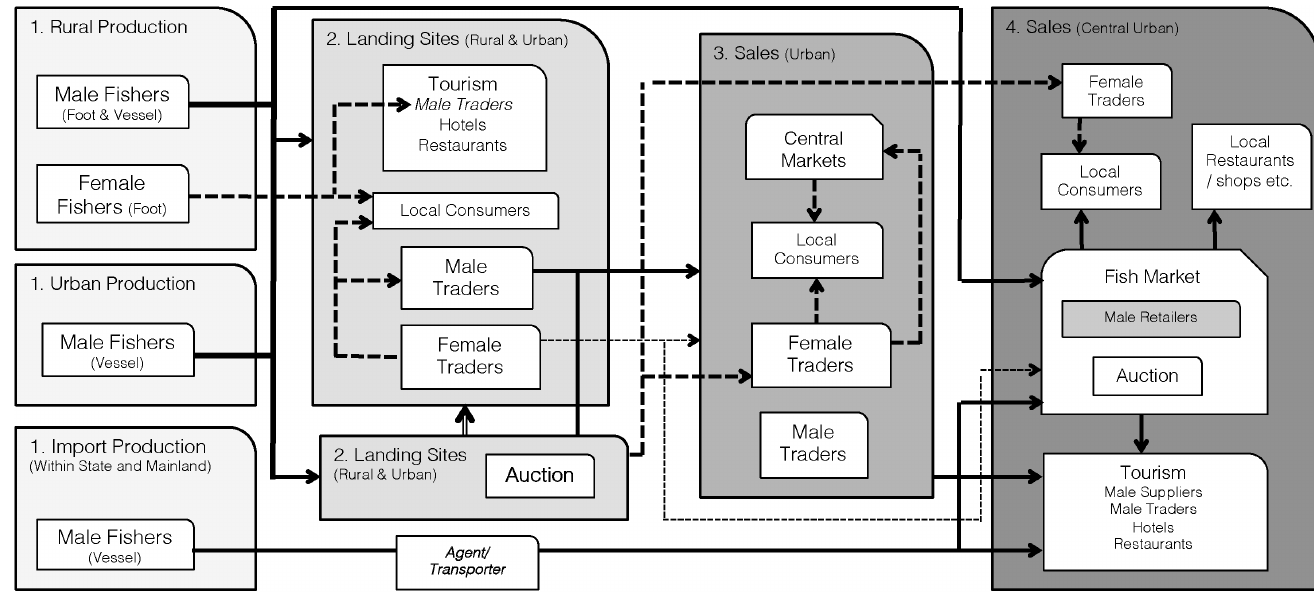
Figure A5.1: Market structure for Concepcion Municipality, Philippines. Dotted arrows represent the product being sold by women actors, the bold line represents men actors and the double line shows both women and men transactions. Different sized arrows are used only for clarity.